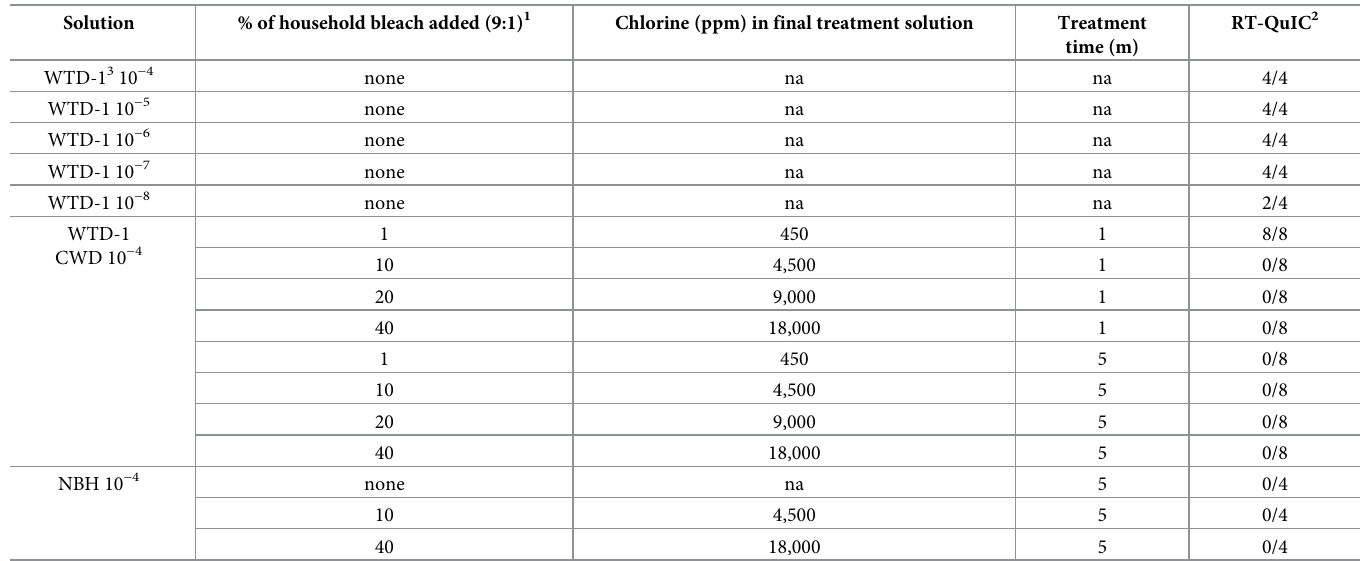
Table 1. CWD-solution decontamination. Solution